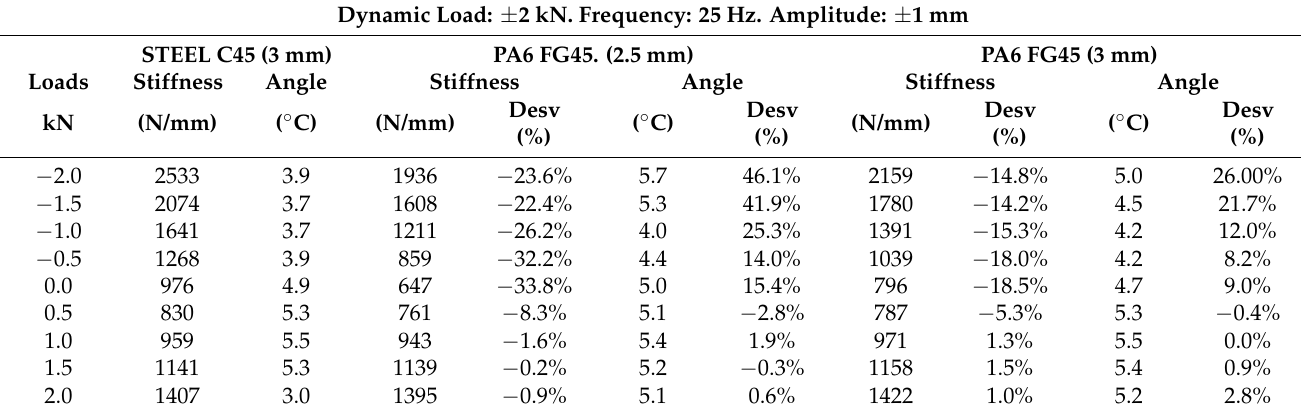
Table 4. Results from the Axial dynamic Test (Pre-FAT) of the assembly prototype.